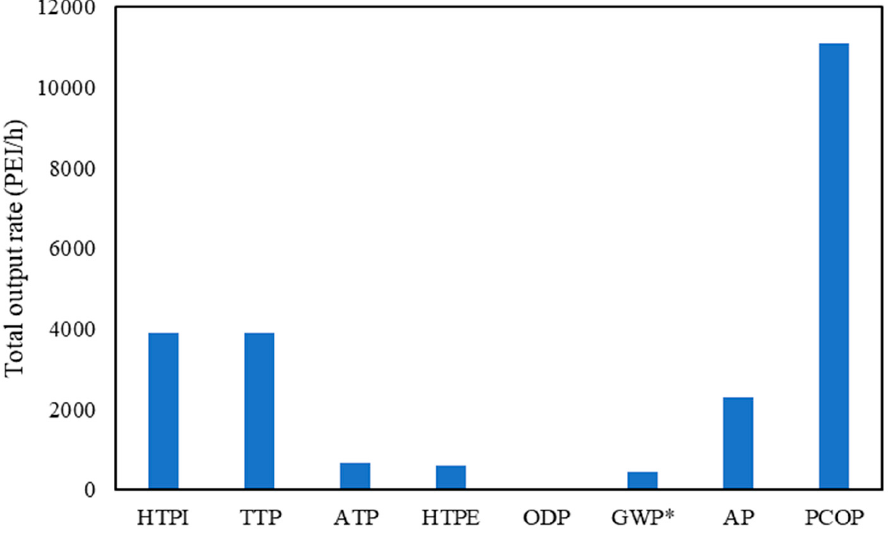
Figure 8. Categories environmental impacts for chitosan production from shrimp exoskeleton (* 10 2 ). Adapted from: [13].